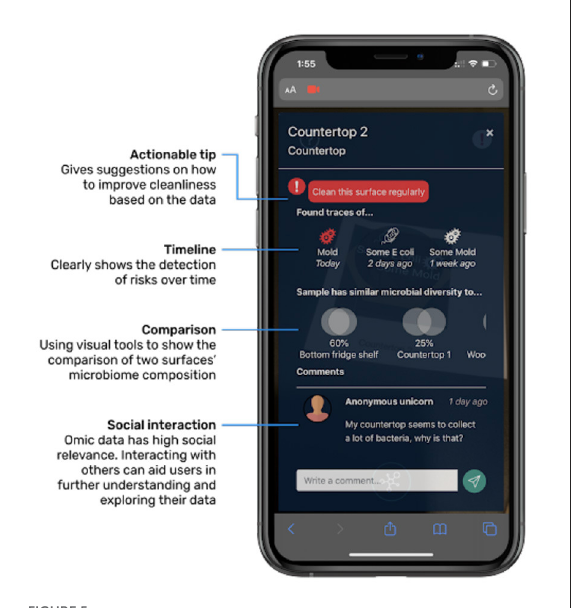
FIGURE3 Close-up of a marker from the application that shows AR information (what the mobile app shows in Figure 4).